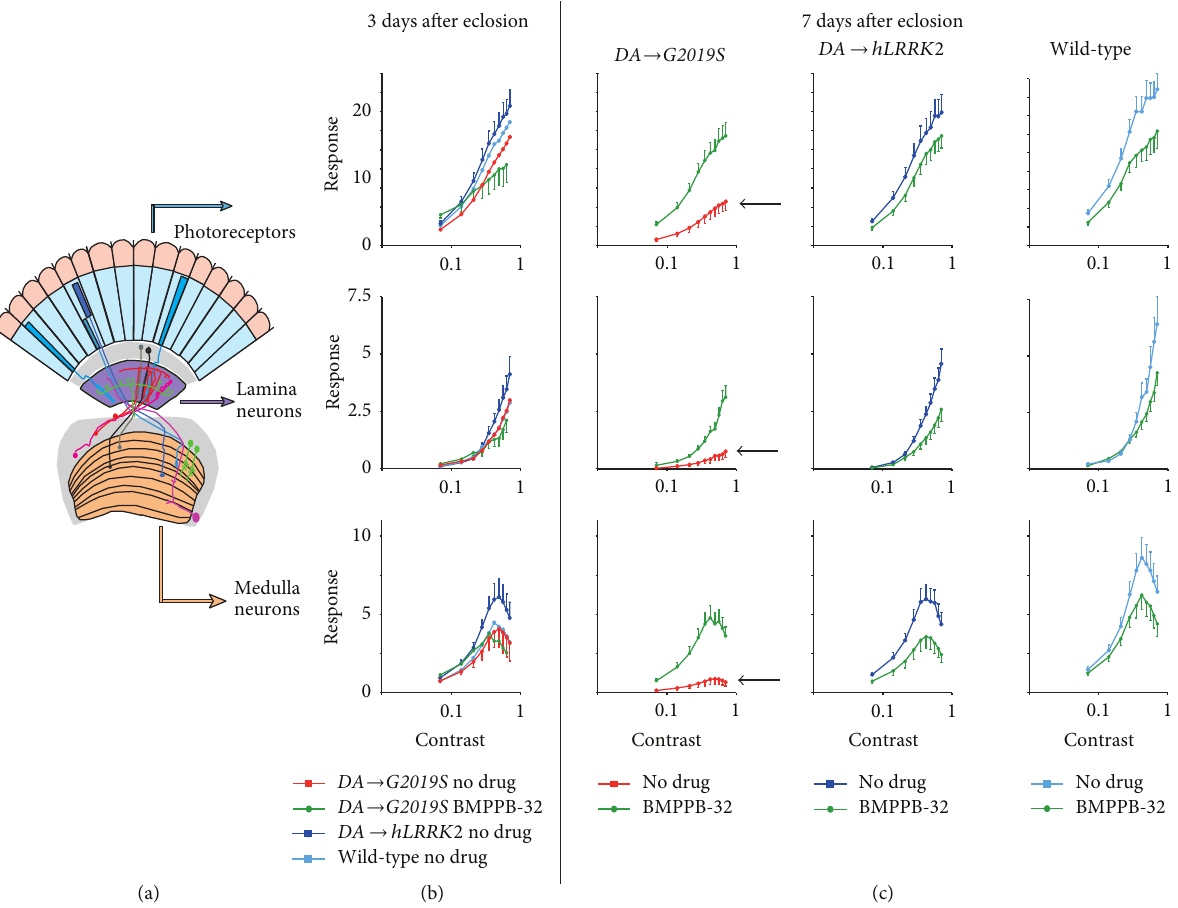
Figure 6: Rescue of dopaminergic LRRK2-G2019S visual neurophysiology by BMPPB-32 only applied during adult life. (a) Diagram of the fly eye, showing the lens (red), photoreceptors (blue), second-order lamina (purple), and third/fourth-order medulla (orange). Dopaminergic neurons are shown in green. When illuminated with flickering blue light, the overall (field) potential we record is separated by the fast Fourier transform (FFT) into components corresponding to the photoreceptor, lamina, and medulla neurons, respectively, details in [15]. (b) Larvae were raised on drug free food and some transferred to food containing 2.5 𝜇 M of the specific LRRK2 kinase inhibitor BMPPB-32 [15] on the first day of adult life. After 3 days, the contrast/response function (CRF) of flies expressing LRRK2-G2019S in the dopaminergic neurons ( DA → G2019S ) is indistinguishable from flies expressing hLRRK2 or to those not expressing any transgene. BMPPB-32 application has no effect. (c) At 7 days, the DA → G2019S flies show very much reduced CRFs, well below the controls. BMPPB-32 restores the visual function to within 30% of the controls. There is no statistically significant effect of this drug on the control genotypes. Genotypes as in [15]; data not previously